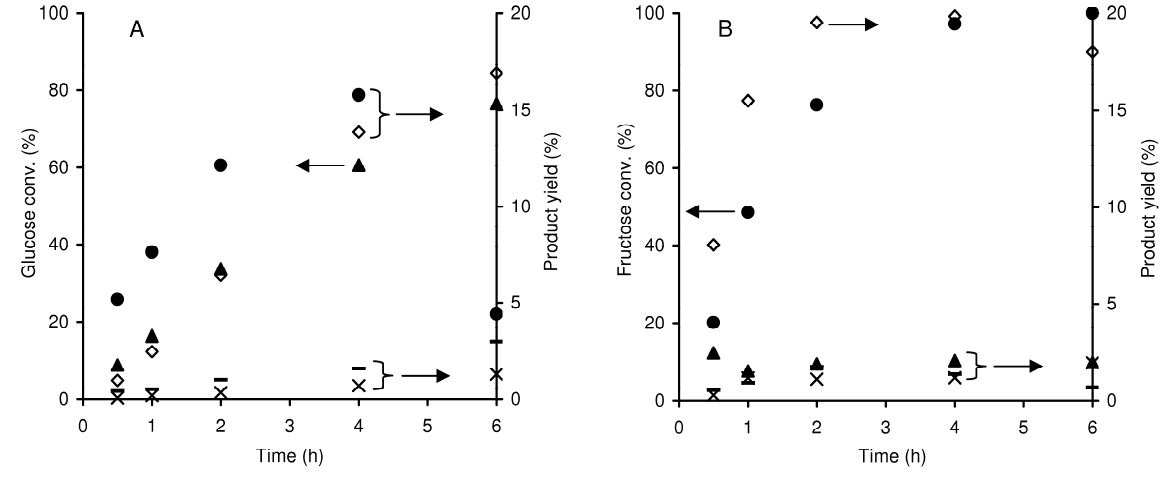
Figure 8. Reaction of glucose (A: ( ▲ ) conversion; ( ● ) fructose yield), and reaction of fructose (B: ( ● ) conversion; ( ▲ ) glucose yield), in the presence of Al-TUD-1 at 170 ºC. The HMF (  ), ( − ) mannose and FUR ( × ) yields are also